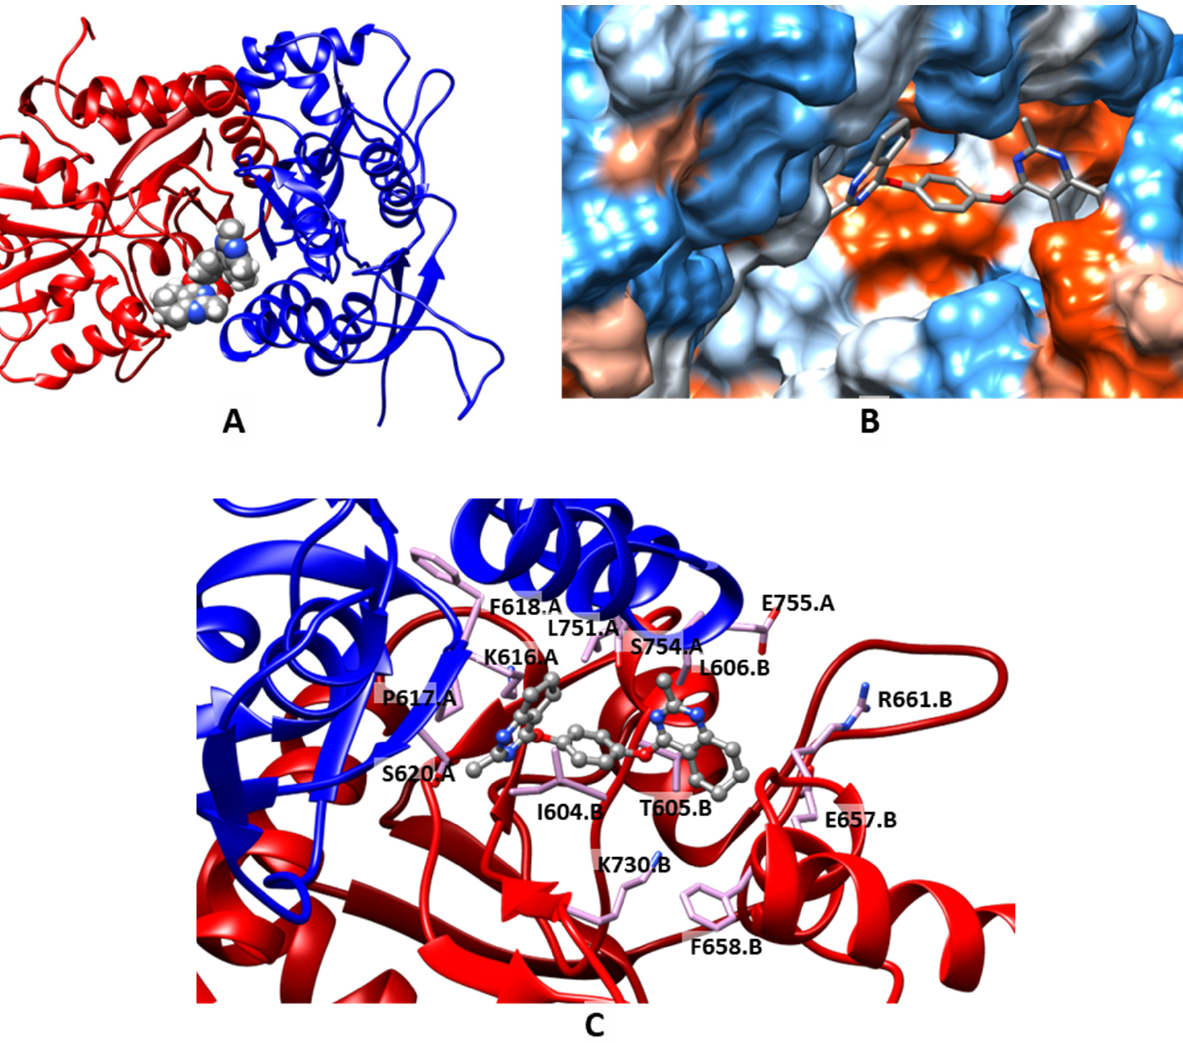
Figure 5. Binding mode of the NAM 1j , refined using molecular dynamics simulation (150 ns). ( A ) General view of the dimeric ligand binding domain of AMPA receptor (GluA2) and location of the binding site. ( B ) Binding pockets in the protein molecular surface colored by local hydropho ‐ bicity (brown for hydrophobic and blue for hydrophilic). ( C ) Detailed view of the binding site. The ligand is represented by a grey ball ‐ and ‐ stick model, the amino acid residues located within 3 Å of it are represented by pink stick models.